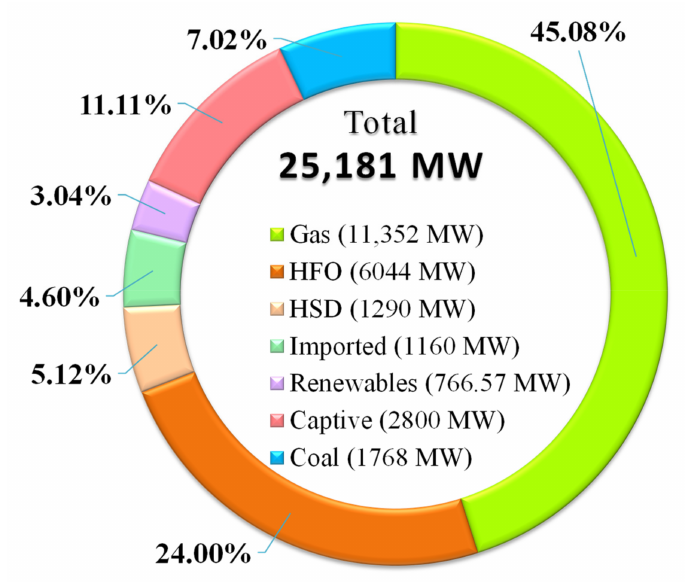
Figure 2. Current electricity generation mix in Bangladesh (authors’ creation based on SREDA [21] data).